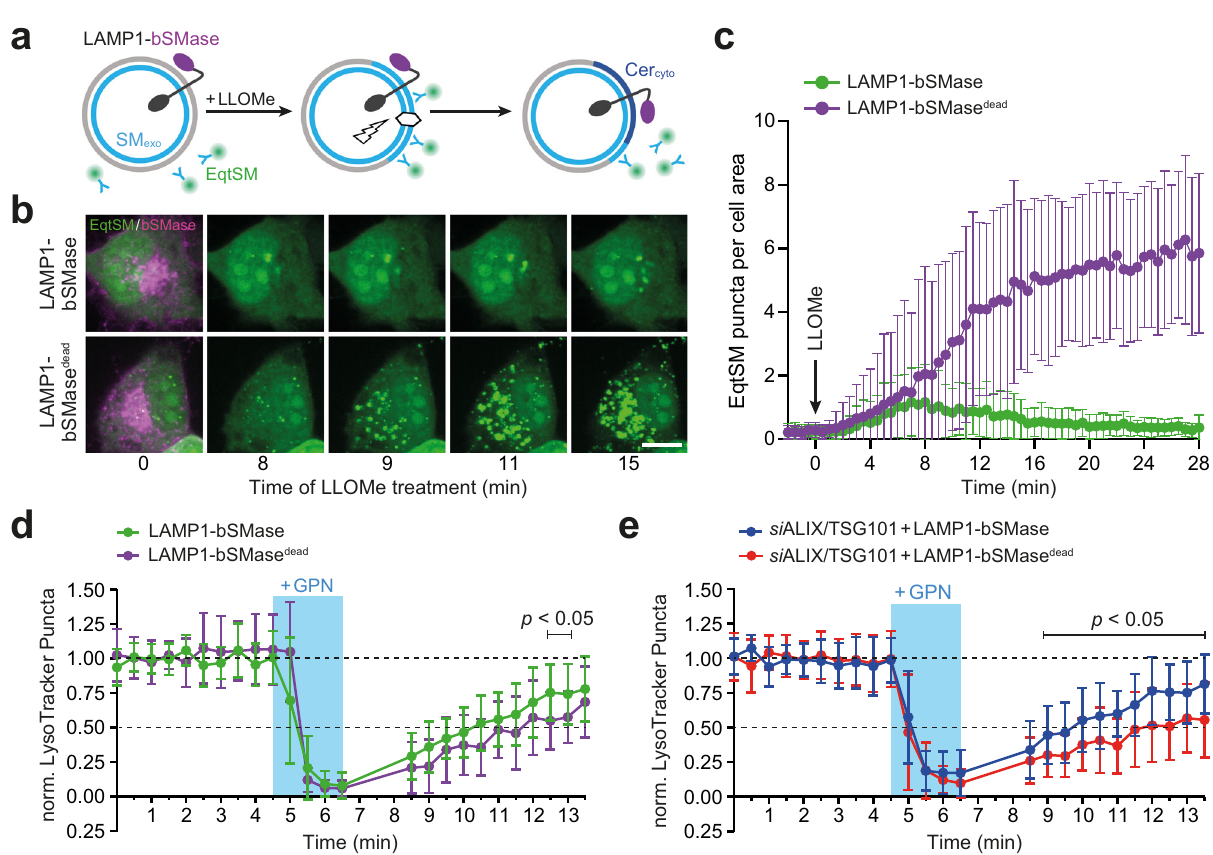
Fig. 6 Hydrolysis of cytosolic SM promotes lysosomal repair in ESCRT-compromised cells. a Bacterial SMase (bSMase, magenta) was fused to the C - terminus of lysosomal membrane protein LAMP1, enabling an ef fi cient metabolic turnover of SM translocated to the cytosolic surface of LLOMe-damaged lysosomes. b Time-lapse images of HeLa cells co-expressing GFP/V5-tagged LAMP1-bSMase or LAMP1-bSMase dead (magenta) and mKate-tagged EqtSM (green) treated with 1 mM LLOMe for the indicated time. Scale bar, 10 µ m. c Time-course plotting EqtSM-positive puncta per 100 μ m 2 cell area in cells treated as in ( b ). Data are means ± SD. n = 14 cells per condition over two independent experiments. d Time-course plotting LysoTracker-positive puncta in HeLa cells co-expressing GFP/V5-tagged LAMP1-bSMase or LAMP1-bSMase dead and mKate-tagged EqtSM during and after a 2-min pulse of GPN, normalized to the initial number of puncta. Data are means ± SD. n = 16 cells for LAMP1-bSMase and 20 cells for LAMP1-bSMase dead over three independent experiments. P values were calculated by unpaired two-tailed t test. e Time-course plotting LysoTracker-positive puncta in HeLa cells pre- treated with siRNAs targeting ALIX/TSG101 (72 h) and expressing LAMP1-bSMase or LAMP1-bSMase dead during and after a 2-min pulse of GPN. Data are means ± SD. n = 23 cells for si ALIX/TSG101 + LAMP1-bSMase and 29 cells for si ALIX/TSG101 + LAMP1-bSMase dead over three independent experiments. P values were calculated by unpaired two-tailed t Maxima TM SYBR TM Green/ROX 2x qPCR Master Mix (Thermo Fisher Scienti fi c, K0221). Each reaction contained 400 ng of cDNA and 0.3µM each of sense and antisense primers in a total volume of 10 µl. Initial denaturation was at 95 °C for 10min. Cycles ( n = 40) consisted of 10 s denaturation at 95°C, 30s annealing at 57°C and 30s of extension at 72 °C. Analysis of a single PCR product was con- fi rmed by melt-curve analysis. All reactions were performed in triplicate. Expres- sion data were normalized using actin as a reference. Ct values were converted to mean normalized expression using the 2 - ΔΔ Ct method 48 and CFX Manager soft-